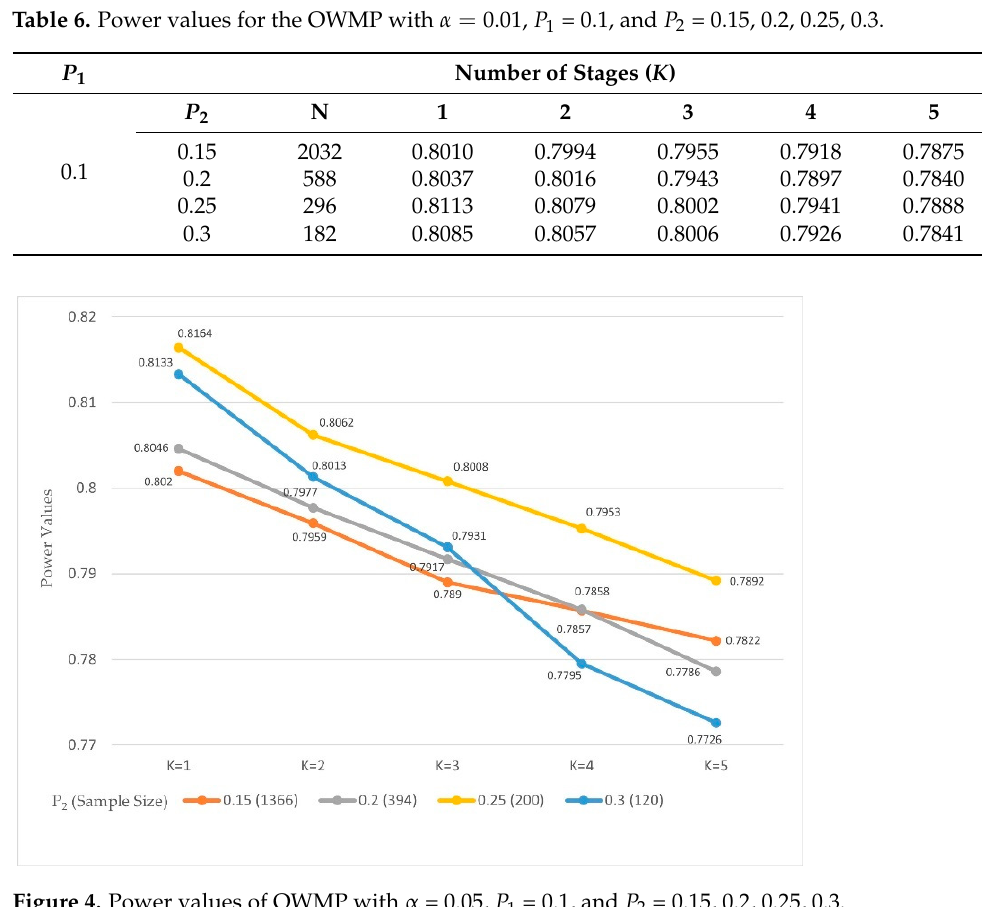
0.7841 Figure 5. Power values for OWMP with α = 0.01, 𝑃 (cid:2869) = 0.1, and 𝑃 (cid:2870) = 0.15, 0.2, 0.25, 0.3. The probability value 𝑃 (cid:2869) = 0.1 was fixed, and the power rates with various values for 𝑃 (cid:2870) = 0.15, 0.2, 0.25 , and 0.3 , were studied. The sample sizes 1366, 396, 200, and 120 for 𝛼 = 0.05 , and 2032, 588, 292, and 182 for 𝛼 = 0.01 were used to ensure that the power values were 0.8. It was noticed that with 𝛼 = 0.05, the results for the power values with 𝐾 = 1 were between 0.8046 and 0.8164. Then, the values showed a decreased behavior when the val- ues of 𝐾 were increased because the power values, when 𝐾 = 5, were between 0.7726 and 0.7892, with marginal errors not more than 0.0274 between the power values and the 0.8.